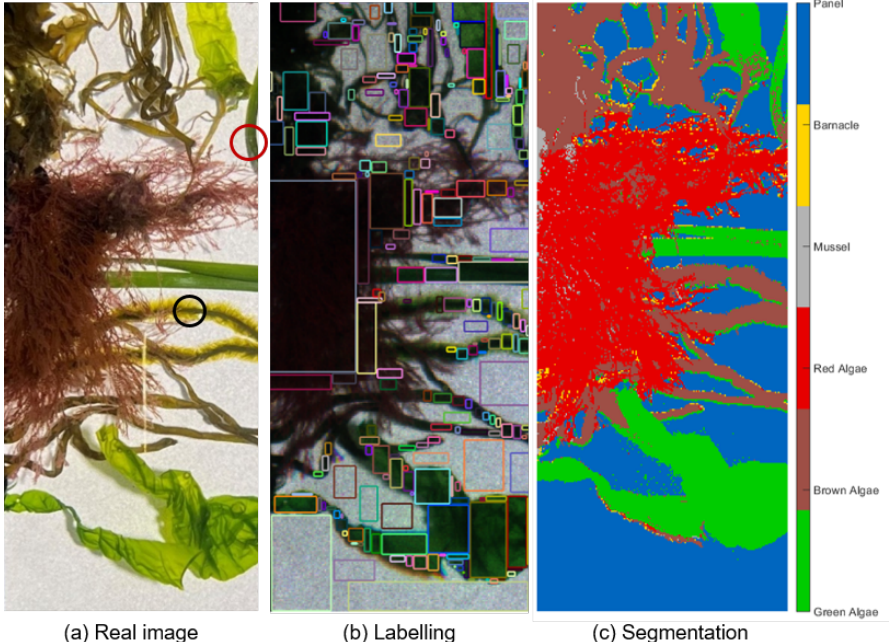
Figure 7. Image of the model target constructed by attaching biofouling collected at the CoaST Maritime Test Centre (CMTC) to a panel coated with a commercial underwater primer. In ( a ), the RGB image where two algae from different groups are encircled (brown in black circle, green in red circle) to demonstrate that different classes can sometimes depict similarities in color. In ( b ), the labeling of the measured hypercube to generate the ground truth. In ( c ), the segmented image resulting from the application of the wide neural network (WNN) classifier to the